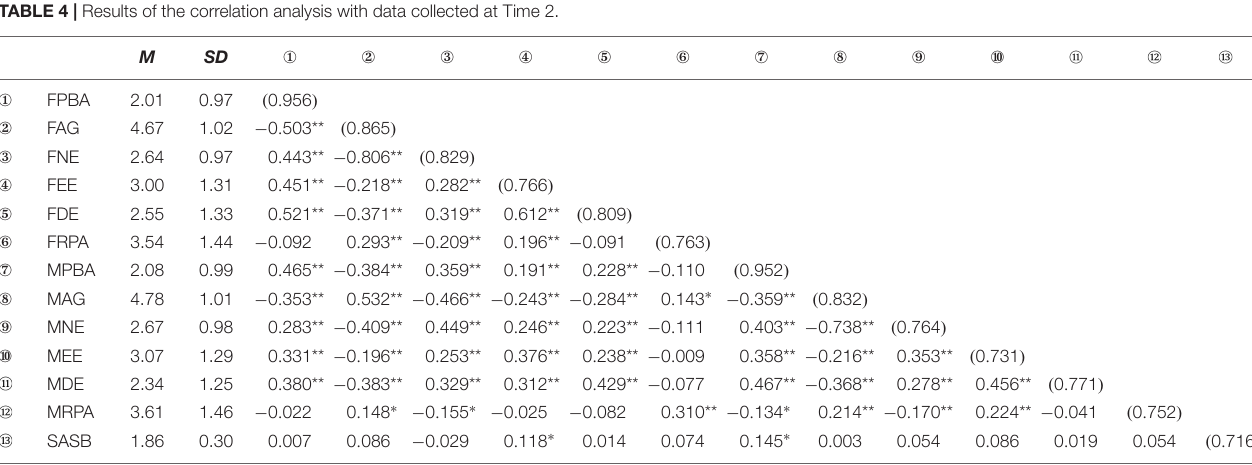
Fathers’ mothers